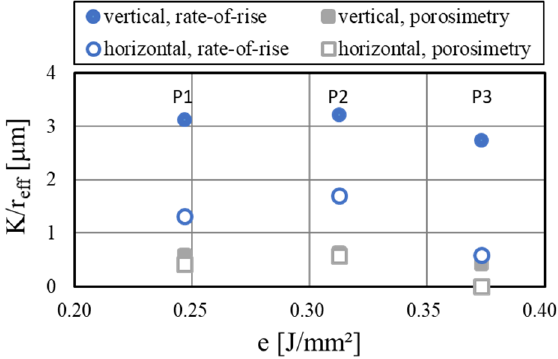
Figure 15. Comparison of the porosimetry and rate-of-rise measurements for the porous wick samples.